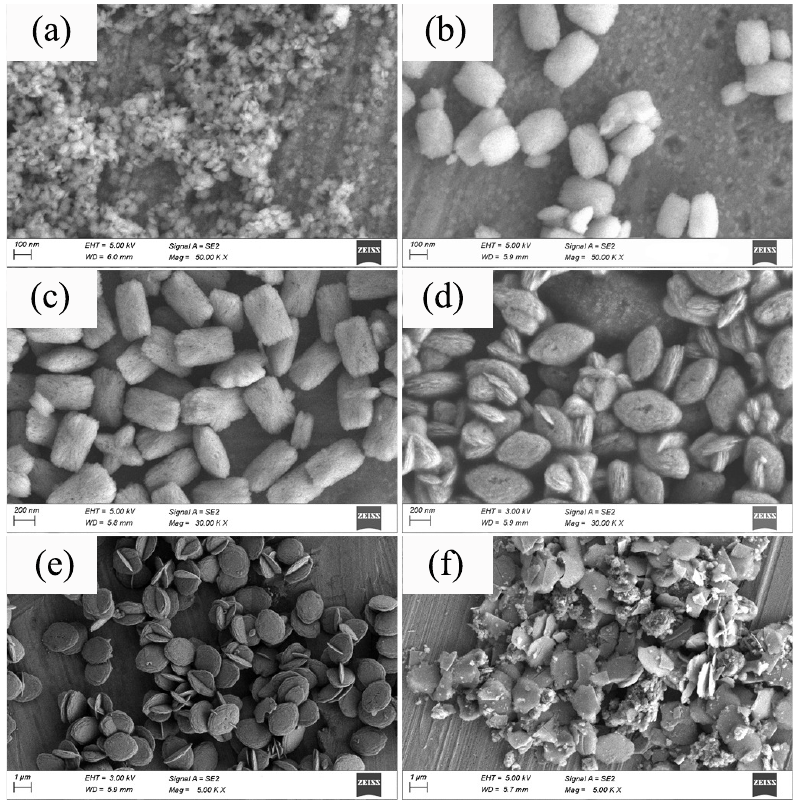
Figure 2. SEM micrographs of HT-ZrO 2 x particles synthesized with different concentration of NaBF 4 . ( a ) x = 0, ( b ) x = 0.005, ( c ) x = 0.01, ( d ) x = 0.02, ( e ) x = 0.03, ( f ) x =